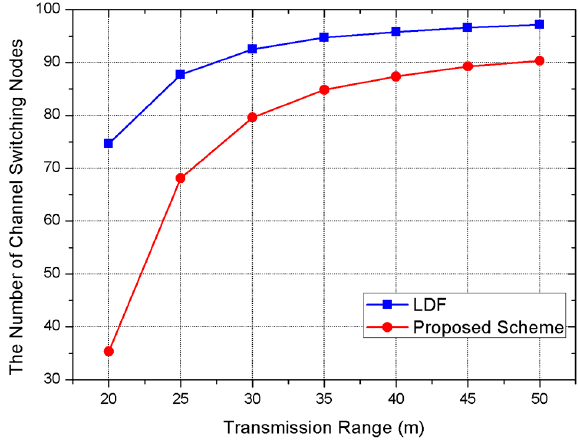
Figure 6. Simulation result on the number of channel switching nodes.